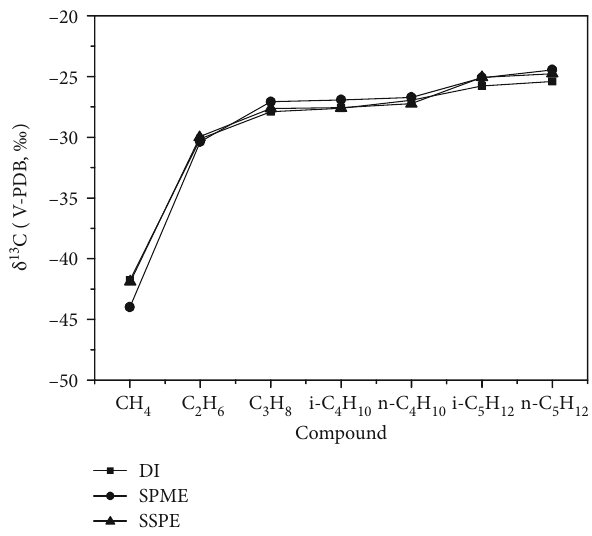
Figure 4: Validation of SSPE. DI: direct injection for original standard natural gas sample; SPME: solid phase microextraction for diluted standard natural gas; SSPE: syringe solid phase for diluted standard natural